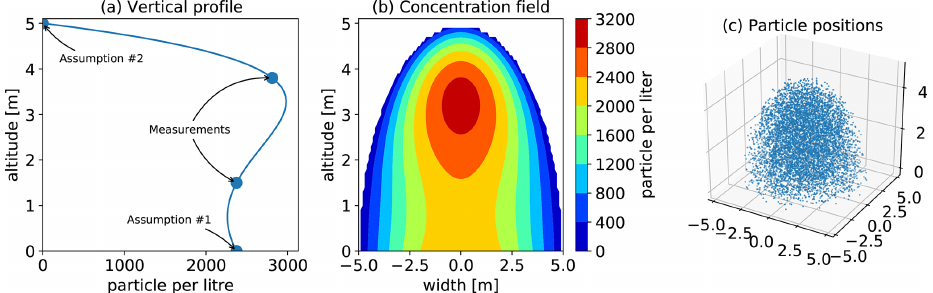
Figure 3. Example construction of an idealised particle cloud. (a) Vertical profile of the cloud centre, derived from EDM measurements. (b) Particle concentration in an ideally shaped cloud. (c) Particle start positions for Itpas.